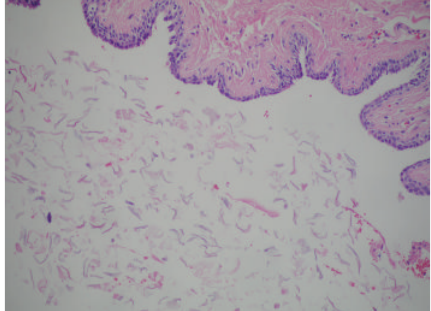
Figure 3: Histopathological section showing a cyst lined by kera- tinized squamous epithelium, cavity filled with lamellated